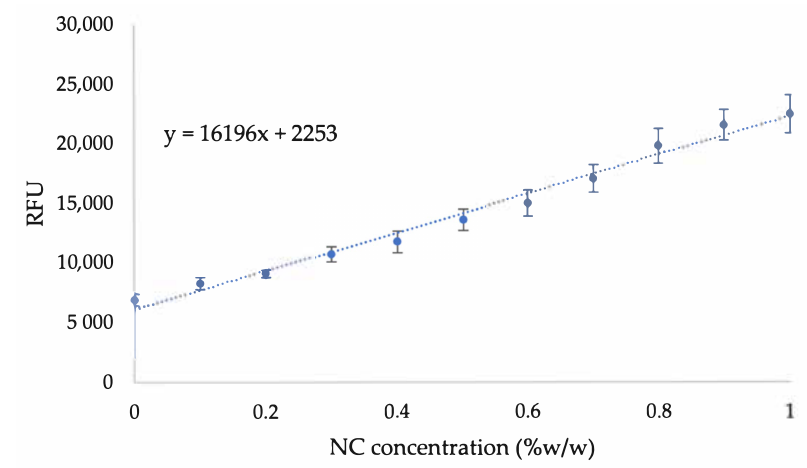
Figure A5. Fluorescence calibration curves of NC treated with CFW stain.